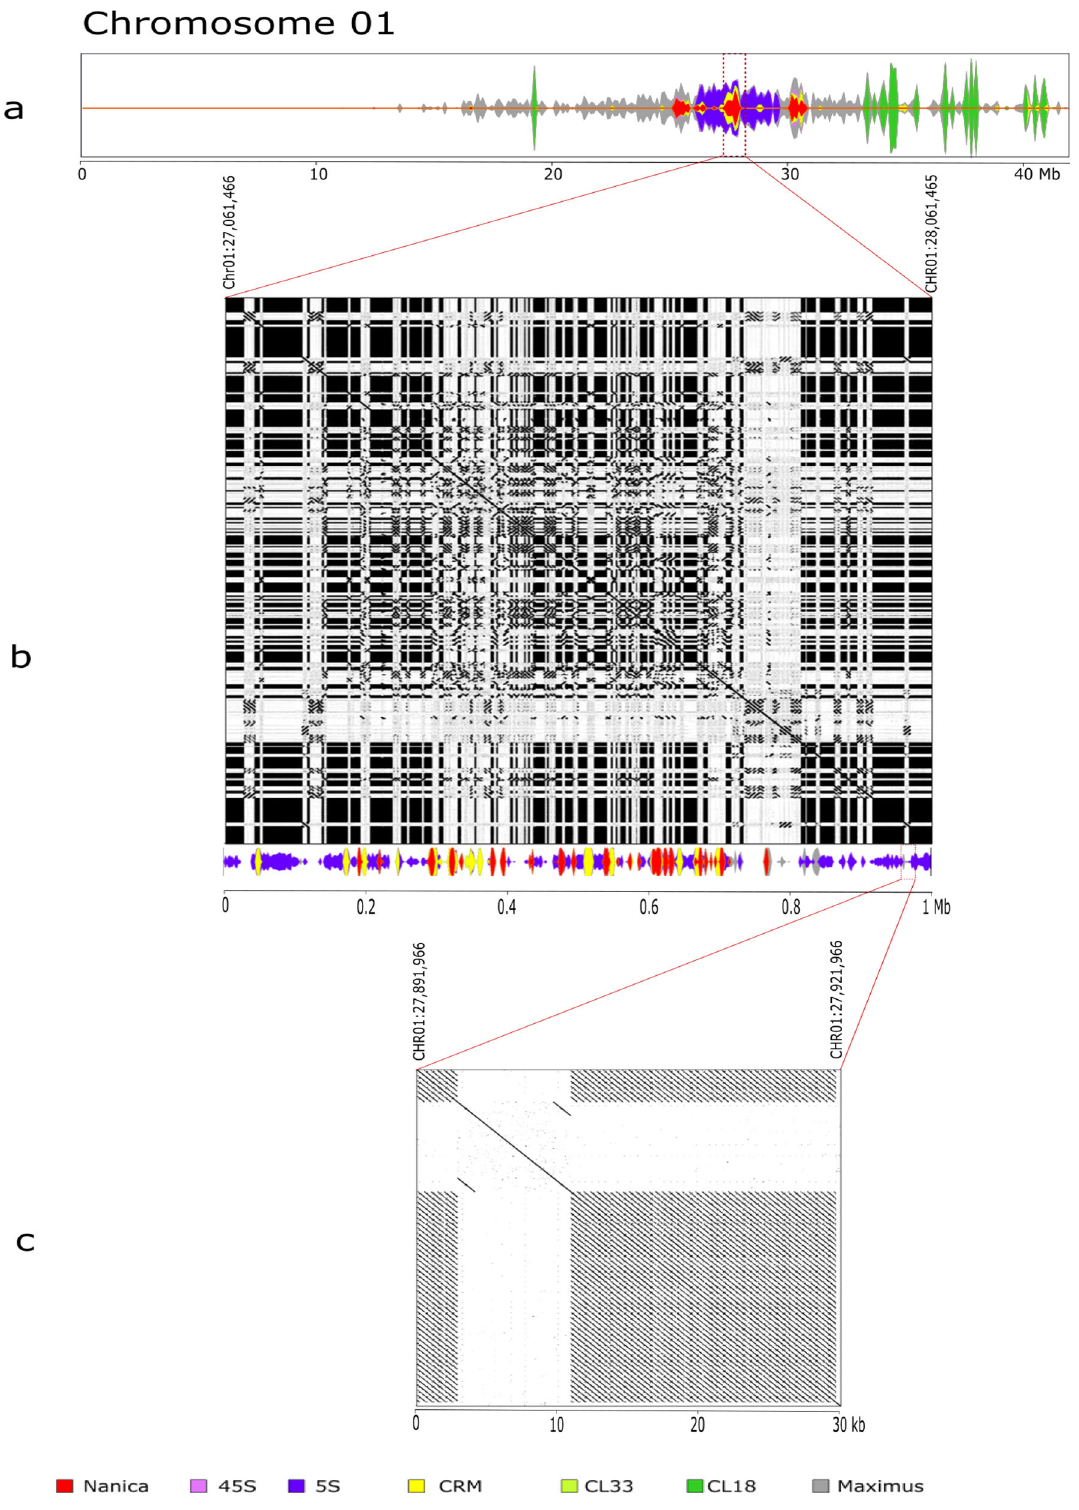
Fig. 3 Fine structure and density of main (peri)centromeric repeated sequences on chromosome 1. Nanica LINE (red), CRM chromovirus Gypsy retrotransposon (yellow), 5S rDNA (lilac), tandem repeat cluster CL18 (dark green), Maximus Copia retrotransposon (gray) are represented on: ( a ) the entire chromosome 1: ( b ) a zoom and a dot-plot alignment of a 1 Mbp segment in the centromeric region containing Nanica, 5S rDNA, and CMR repeats, ( c ) a zoom and a dot-plot alignment of a 30 kbp segment containing 5S rDNA repeats and a